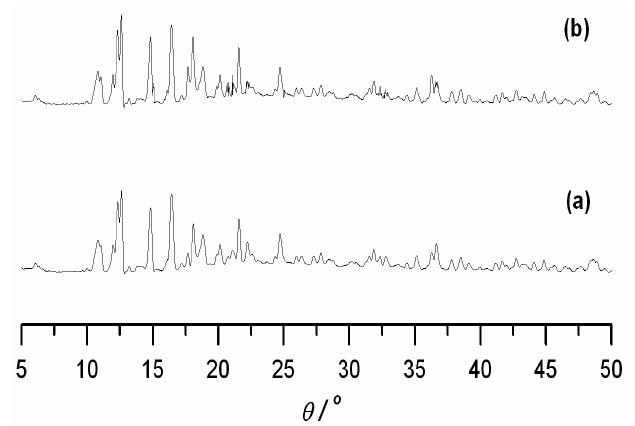
Figure 5. XRD patterns for compound 2 . ( a ) No adsorption of water molecules; ( b ) After adsorption of water molecules.